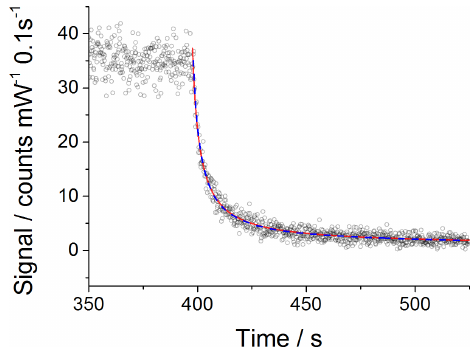
Figure 1. An example of a second-order decay of the FAGE CH 3 O 2 signal (normalised for laser power fluctuations) with 0.1s time resolution (black open circles) recorded at 295K and a 1000mbar air mixture. CH 3 O 2 was generated using [Cl 2 ] of ∼ 1 . 1 × 10 14 moleculecm − 1 and [CH 4 ] of ∼ 2 . 5 × 10 16 moleculecm − 3 . At time zero ( ∼ 400s) the photolysis lamps were turned off to allow the radicals to decay. The data were fit- ted to Eq. (5) (excluding the wall loss rate, k loss ; red line) and Eq. (6) (including k loss ; blue dashed line) using the Levenberg– Marquardt algorithm. The obtained value for the sensitivity = ( 1 . 17 ± 0 . 04 ) × factor was the same for both fits: C CH 3 O 2 10 − 9 countscm 3 molecule − 1 s − 1 mW − 1 . The C CH errors given 3 O 2 above represent statistical uncertainties at the 1 σ level.